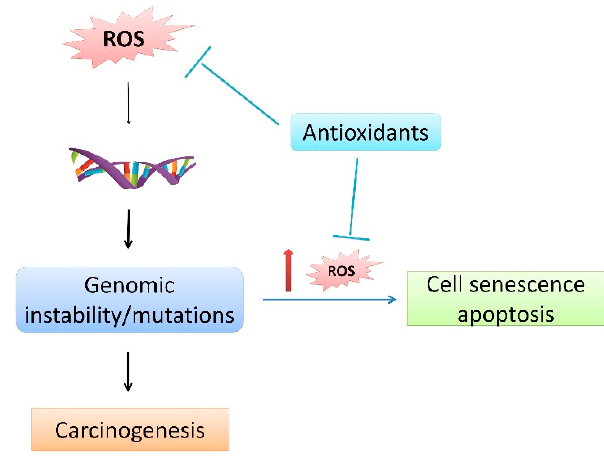
Figure 2. Procarcinogenic and anticarcinogenic roles of ROS.